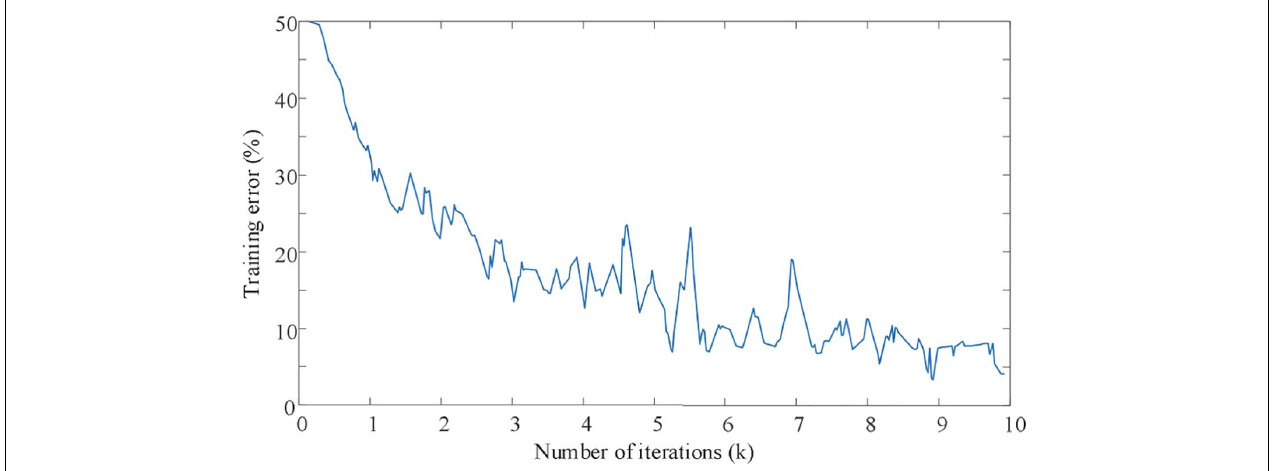
FIGURE 6 | The curve of training error with iteration times.